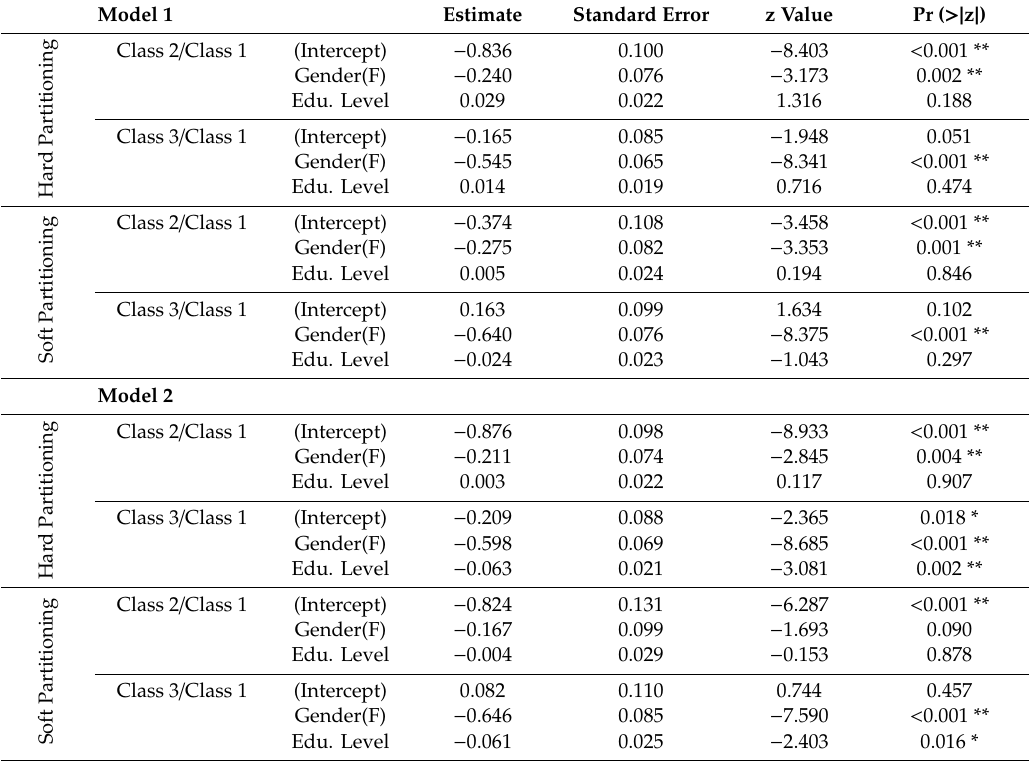
Table 1. Multinomial Logistic Regression Coe ffi cients of gscaLCR with Add Health data.